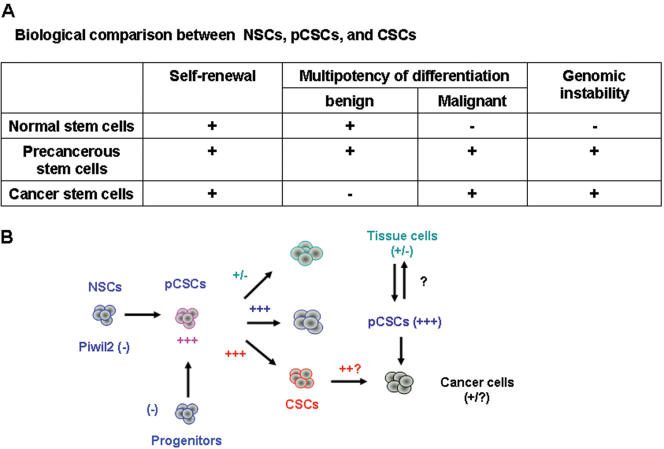
The developmental relationship between pCSC, CSC and cancer.A, Biological comparison between NSCs, pCSCs, and CSCs. B, Schematic model of pCSC development: piwil2 might play an important role in pCSC development.